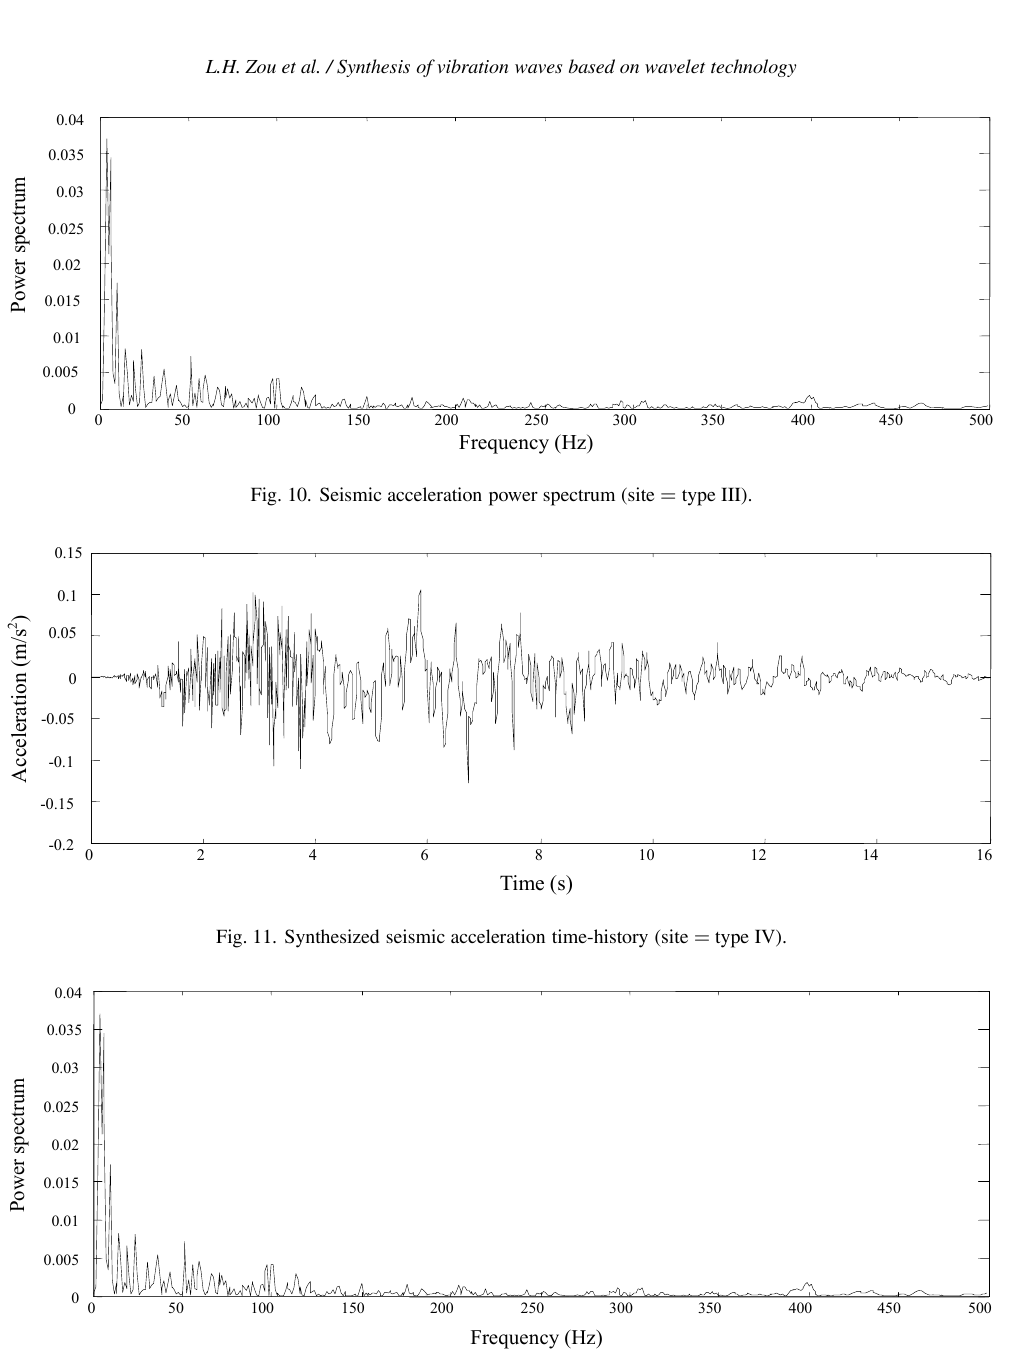
Fig. 12. Seismic acceleration power spectrum (site = type